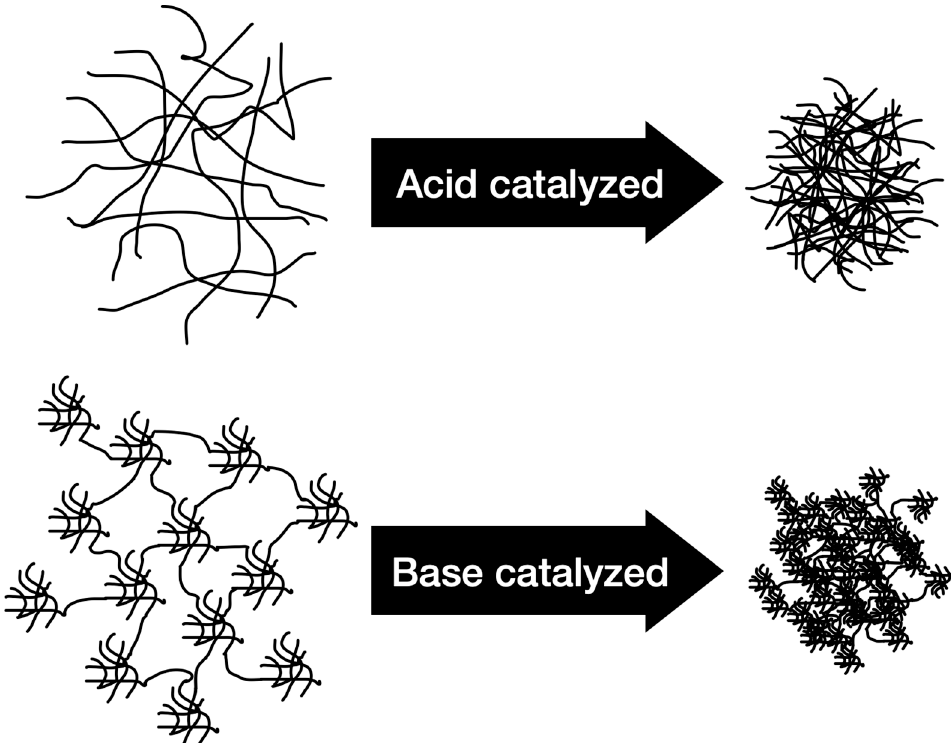
Figure 4. Polymerization behavior after hydrolysis catalyzed with an acid and a base.